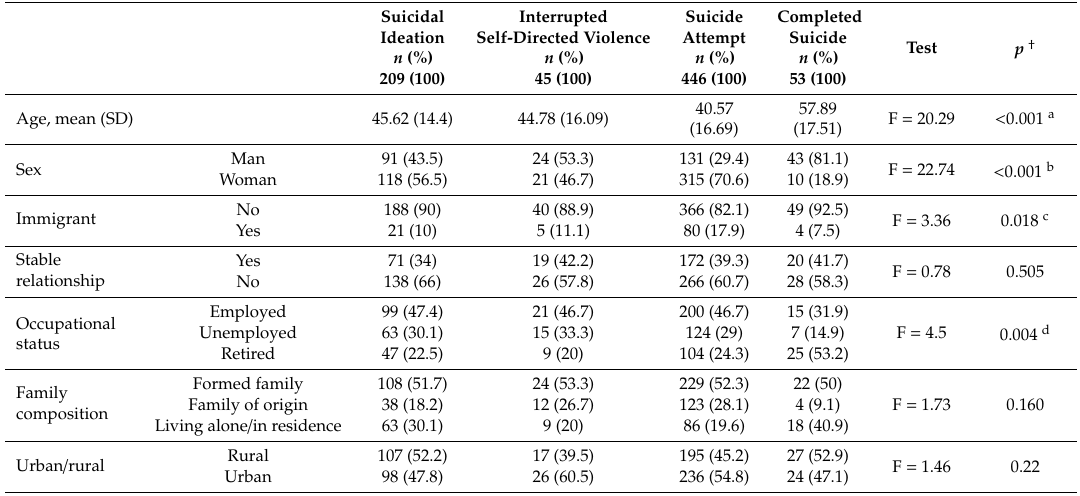
Table 2. Sociodemographic characteristics according to type of suicidal behaviour.